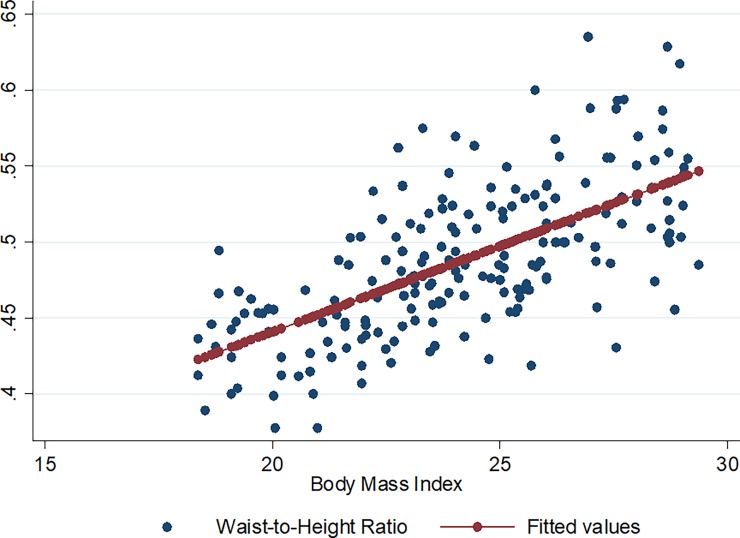
Linear regression model of the association between WHtR and BMI in all study participants.